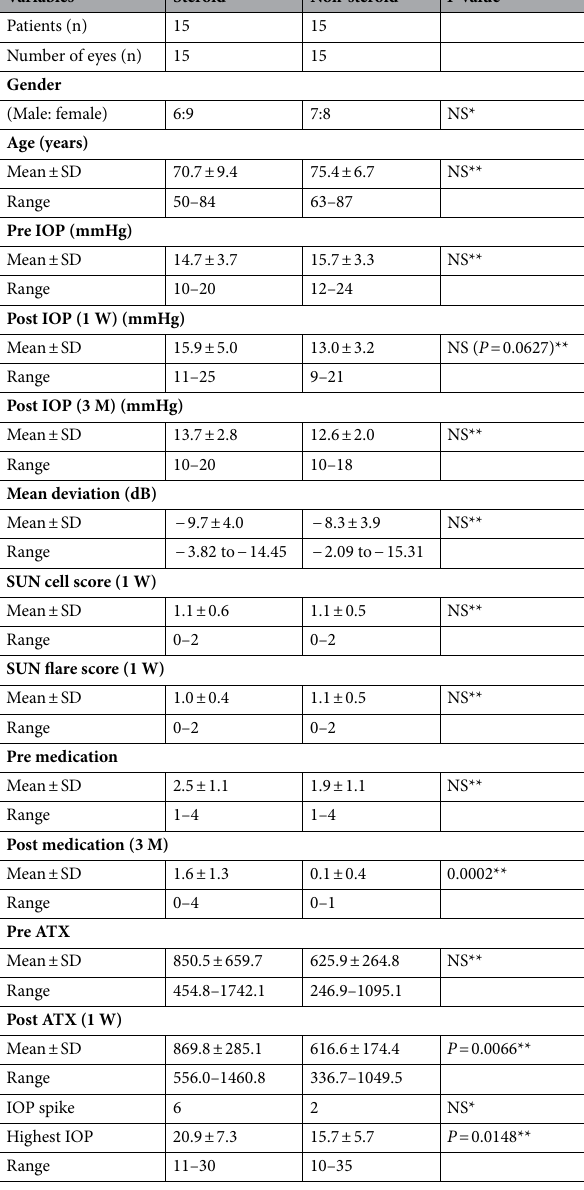
Figure 1C,D illustrates the significant positive correlation between the change in ATX (preoperative vs. 1 week) and △ IOP (1 W − pre) ( P = 0.0132), which persisted at 3 months postoperatively ( P = 0.0036) even though the anti-glaucomatous medications had been added at that time. This suggests a possible relationship between the aqueous ATX level and IOP regulation. The aqueous ATX level at 1 week increased by ≥ 10 µg/L compared with the preoperative level in 15 eyes (50%) in the overall cohort, while the rate of increased ATX was almost the same in both groups (8 and 7 eyes in the non-steroid and steroid groups, respectively). The increased ATX level did not correlate with the △ IOP in the non-steroid group; however, a significant correlation was observed in the steroid group ( P = 0.0164, Fig. 1E). We speculated that the steroid-induced increase in the ATX level may have played a role in IOP elevation seen in some subjects of the steroid group. To determine the factors associated with the number of postoperative medications at 3 months after adjusting for demographic and clinical variables, we performed simple and multiple regression analyses (Table 2). In the simple regression analysis, the highest IOP, steroid use, preoperative and postoperative (1-week) ATX levels, postoperative (1-week) IOP, and number of preoperative medications were positively associated with the number of postoperative medications; age, sex, and pre- and postoperative (3-month) IOP levels were not statistically